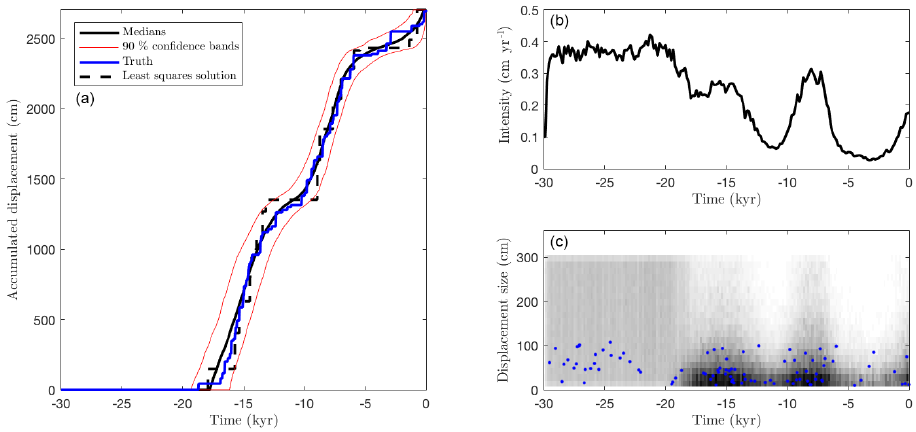
Figure 7. The synthetic case with 16 36 Cl measurements: the accumulated displacement (a) , the mean earthquake intensity (b) , and an event scatter plot (c) showing true events (blue) and events from posterior samples (with gray scale to indicate frequencies).